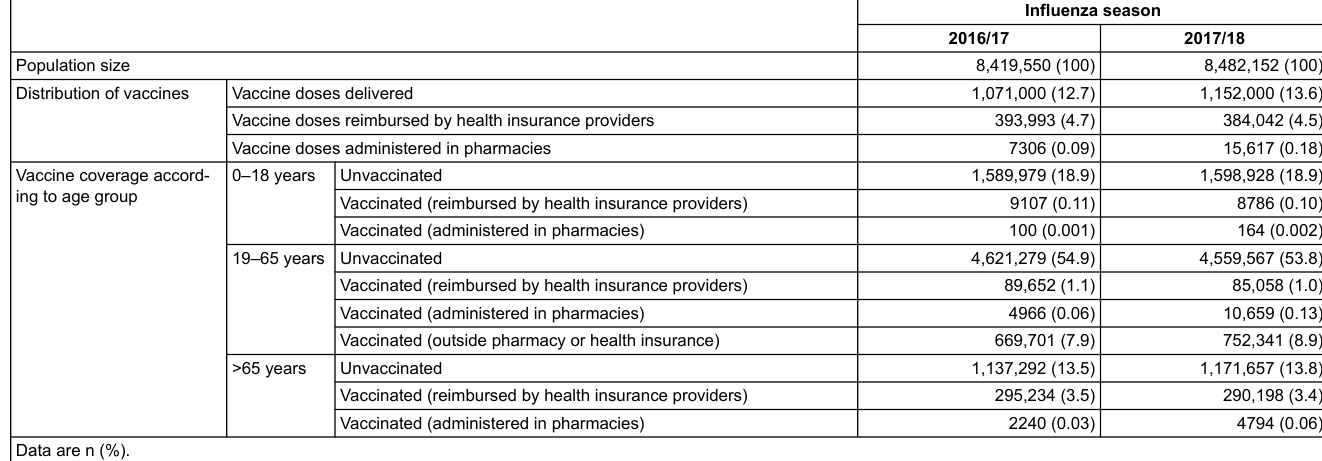
Table 2: Distribution of influenza vaccine in the Swiss population, 2016/17 and 2017/18 influenza seasons.